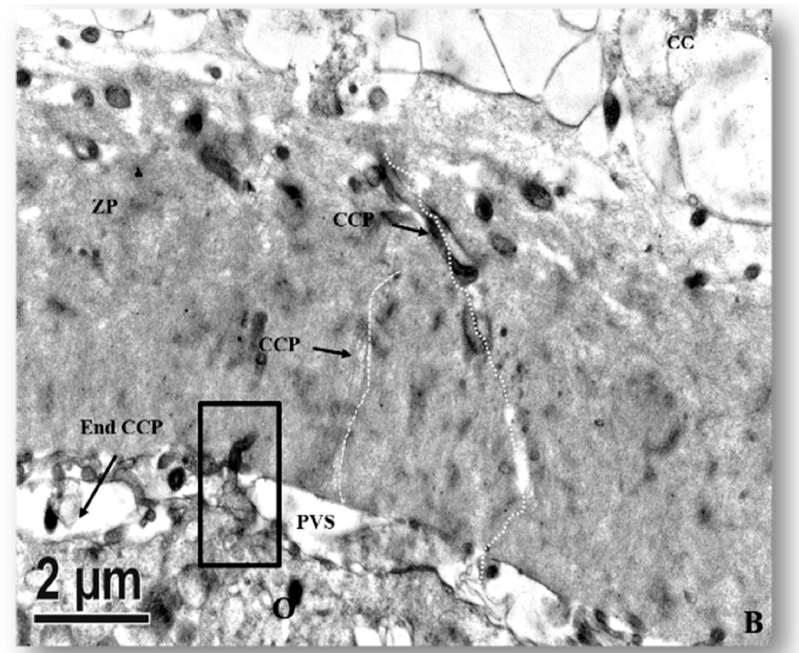
Figure 6. Ultrastructure of the transzona protrusion (TZP) from cumulus cells through the zona pellucida (ZP) to the oolemma membrane. ( A ) Ultrastructural details of cumulus–oocyte complexes showing the ZP is traversed by the cumulus cell projection (CCP) or TZP into the perivitelline space (PVS). ( B ) Zona pellucida of an immature oocyte presenting some CCPs that either end in the PVS (arrow) or form a tight junction (rectangle box) with the plasma membrane (Mb) of oocytes.